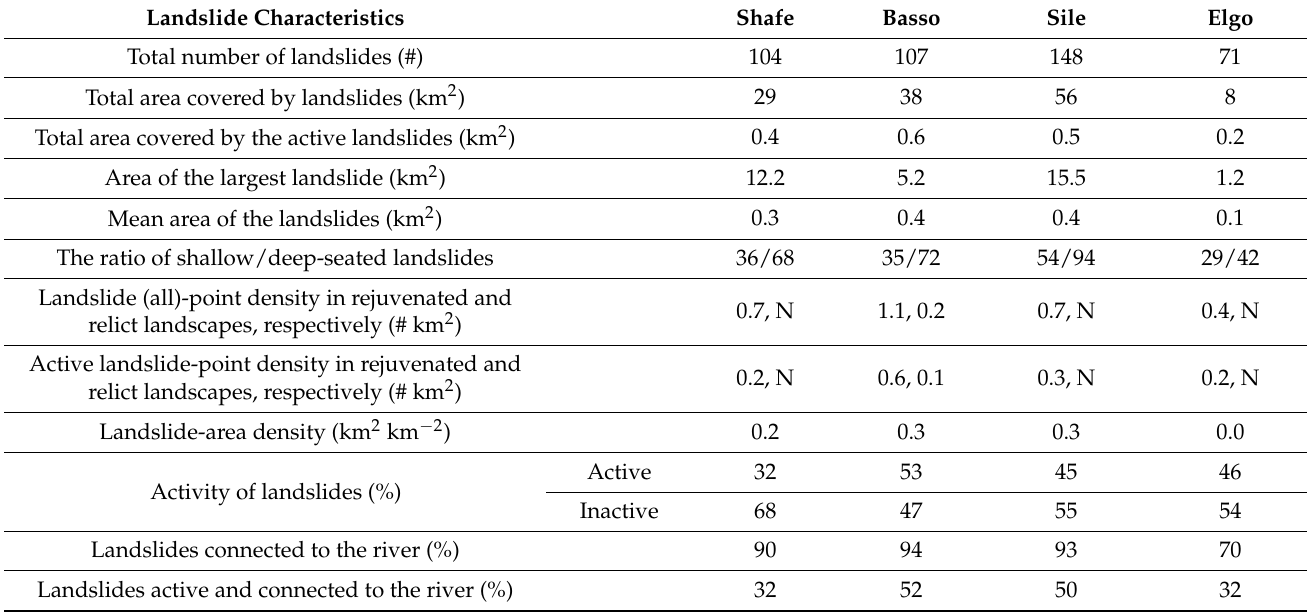
Table 2. Summary of the characteristics of landslides per river